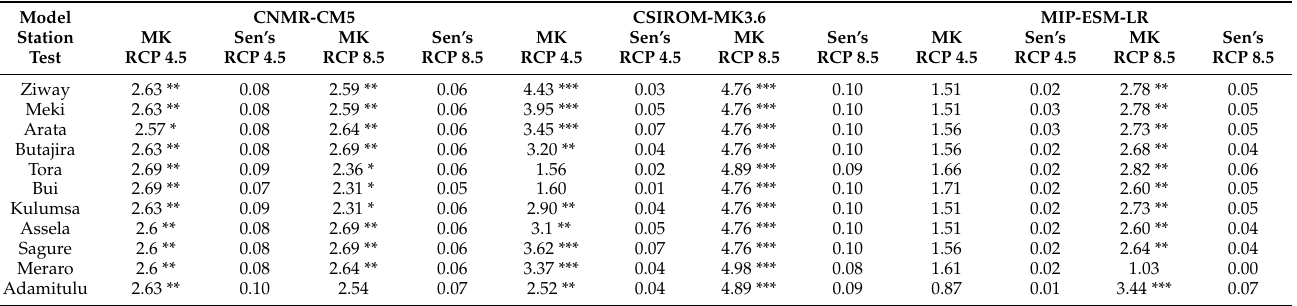
Table A12. Projected Mann–Kendall trend and Sen’s slope estimator results of annual mean T min